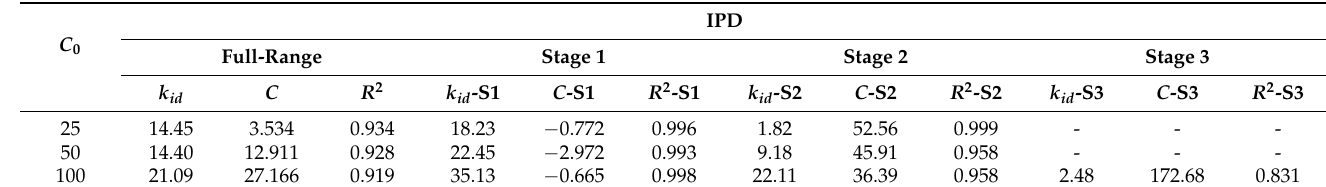
Table 5. Webber–Moriss kinetic model for intra-particle diffusion (IPD). Results presented for the full experemental data and for the assesed three stages. Conditions: as in Table 4.